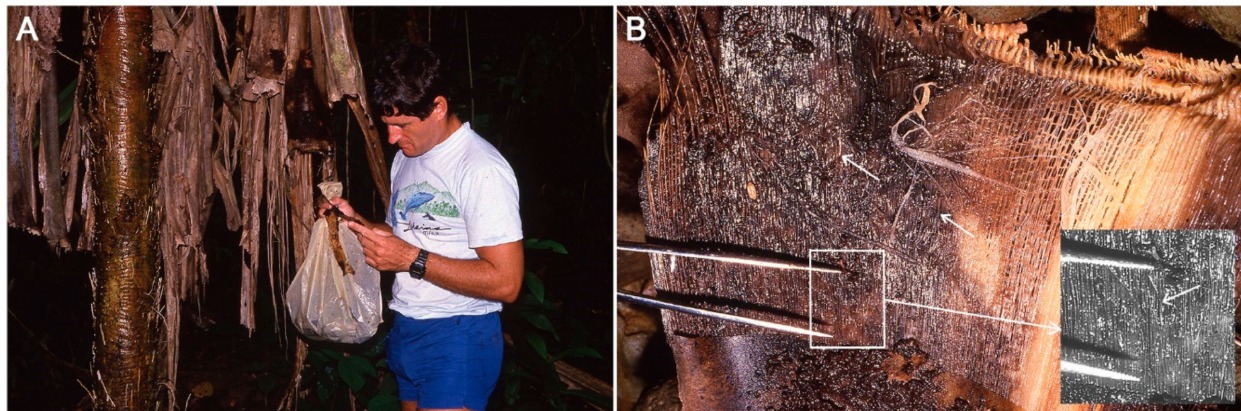
Figure 1. Habitat of Namanereis catarractarum (Nereididae) in the moist dead leaf axils of Pandanus vitiensis beside Savuro Creek near Suva, Fiji. ( A ) Collecting dead leaves for examination in the lab. ( B ) Worms (almost transparent, arrows indicating position) found at the base of dead leaves in the moist layer between the plant fibers. Photographs: C.